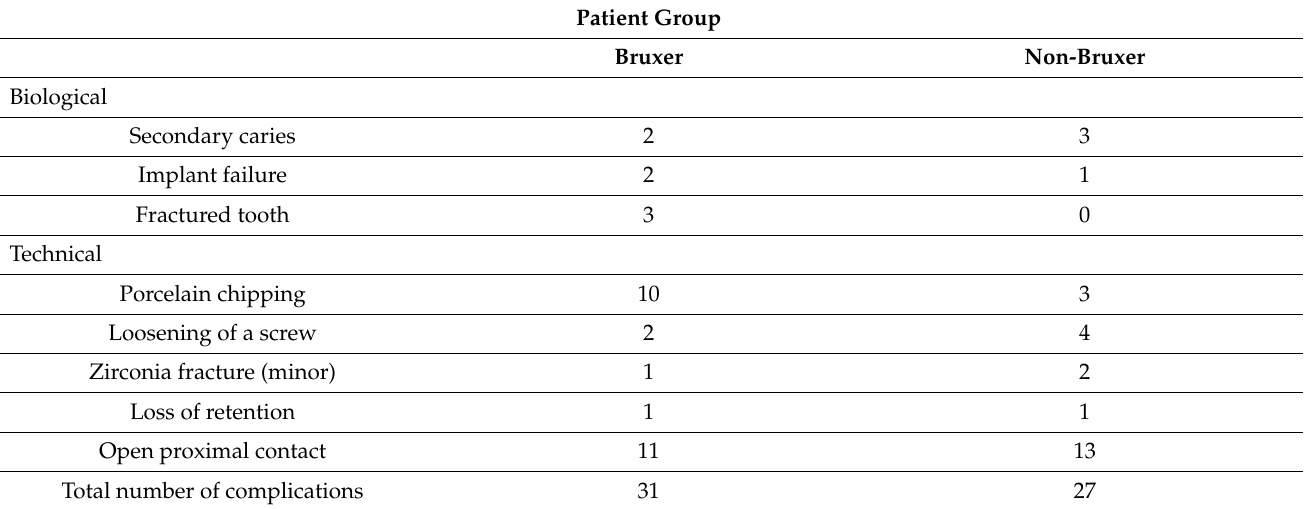
Table 3. Biological and technical complications in both